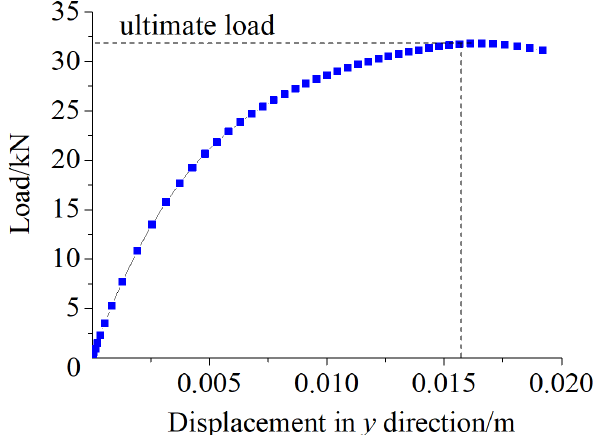
Figure 16: Load- y directional displacement curve